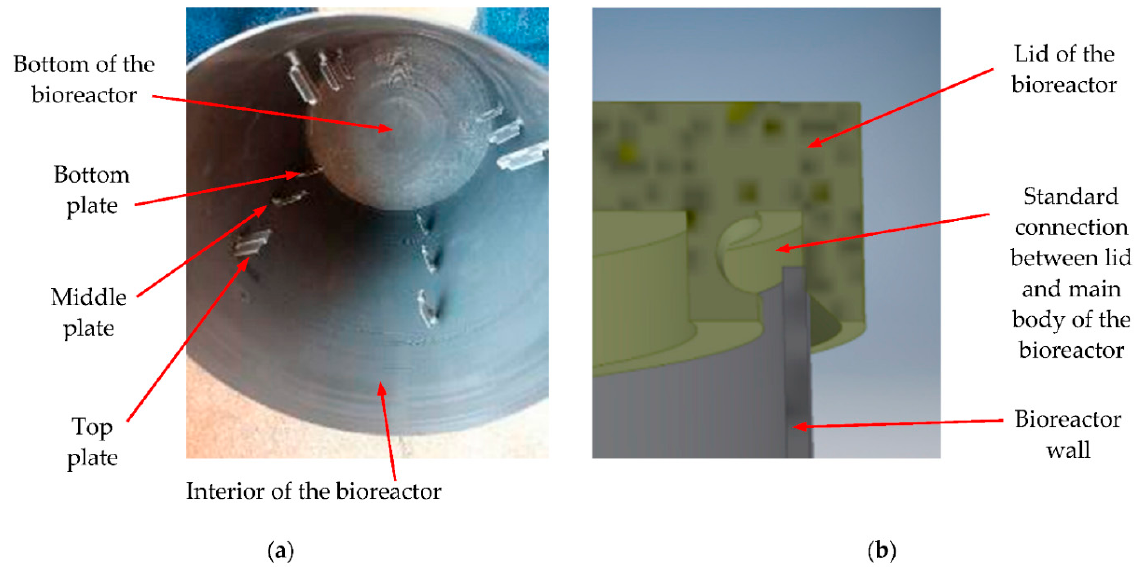
Figure 1. ( a ) Photo of the interior of the reactor before the beginning of the anaerobic process, with the three levels of testing plates; ( b ) connection between the vessel and the lid of the reactor.